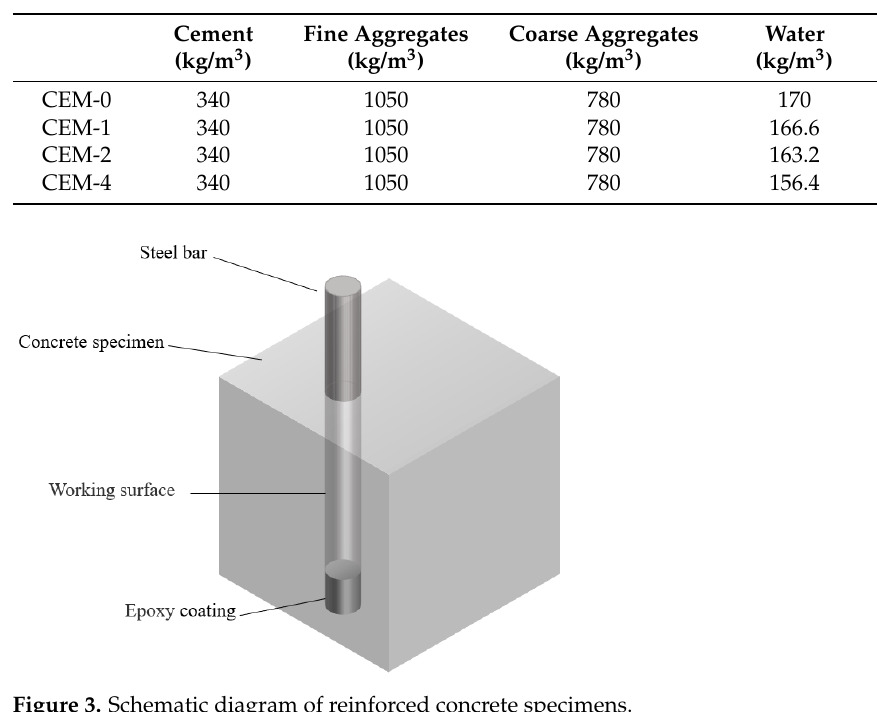
Table 7. Mixture proportions of concrete.